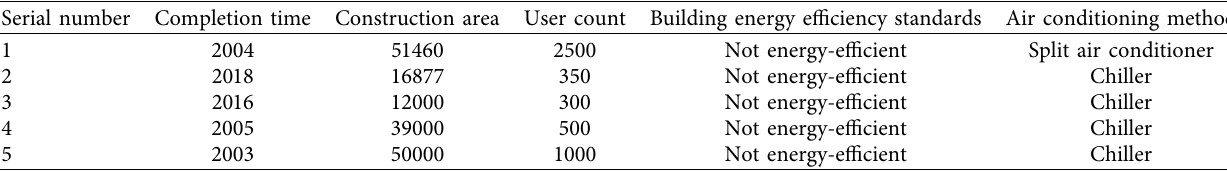
Table 3: Basic information on municipal thermal commercial office buildings.